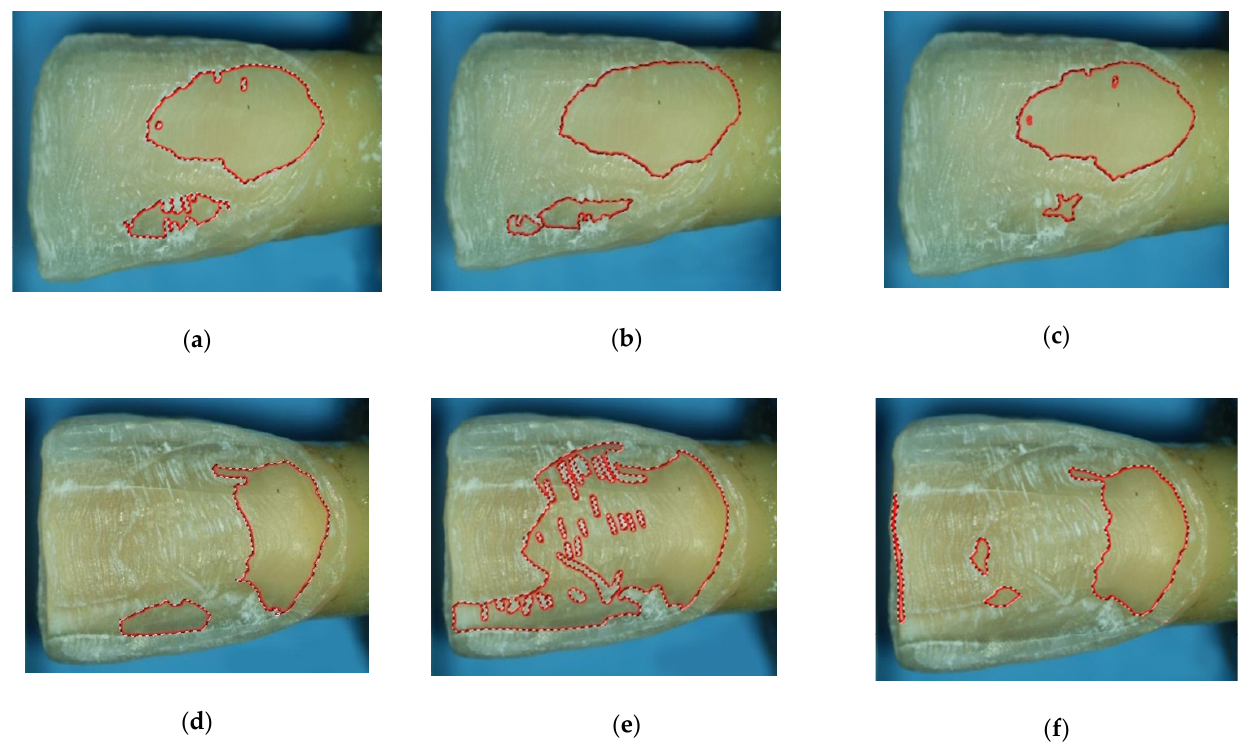
Figure 4. Exposed dentin surfaces were detected through digital analysis and the use of a stereomi- croscope by 3 operators with different clinical expertise for 2 preparation designs. ST, undergraduate student; GP, general practitioner, PR, prosthodontist; WI, window; BJ, butt joint. ( a ) ST/WI; ( b ) GP/WI; ( c ) PR/WI; ( d ) ST/BJ; ( e ) GP/BJ; ( f ) PR/BJ. After tooth preparation, the prepared surfaces were first dried and then photographed with the stereomicroscope. A raster graphics software was used to analyze the pictures taken and to draw the perimeter of dentin tissue.